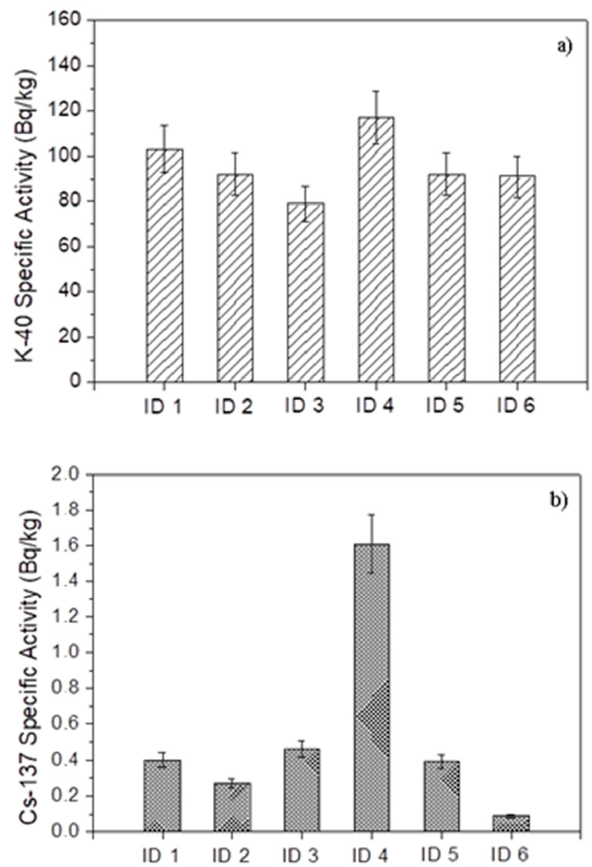
Figure 2. The activity concentration of 40 K ( a ) and 137 Cs ( b ) for the investigated samples in the selected sampling points.